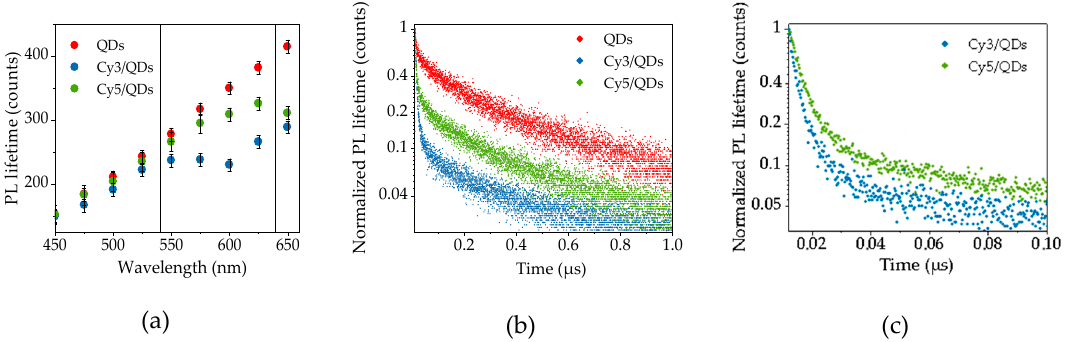
Figure 5. ( a ) The dependence of average PL lifetimes (‹ τ ›) on detection wavelengths; the vertical black lines indicate the gravity centers of the dye absorption ; ( b ) the decay curves at λ exc = 405 nm, λ det = 625 nm of AIS QDs (red) and AIS QDs in complex with Cy3 (blue) and Cy5 (green); ( c ) the decay curves of QD/Cy3 (green) and QD/Cy5 (blue), λ exc = 405 nm, λ det = 585 nm for Cy3 and λ det = 700 nm for Cy5 (the wavelengths of dye PL maxima).